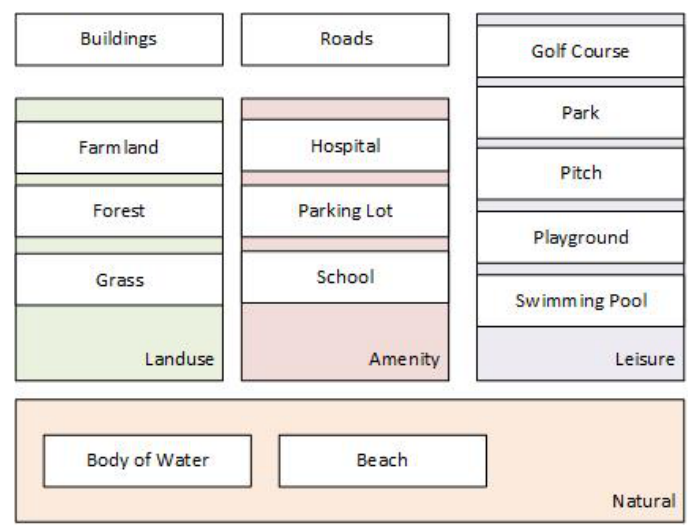
Figure 5. Features currently implemented for the City